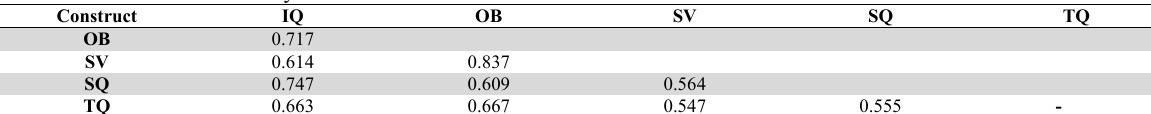
Results of discriminant validity- HTMT method .